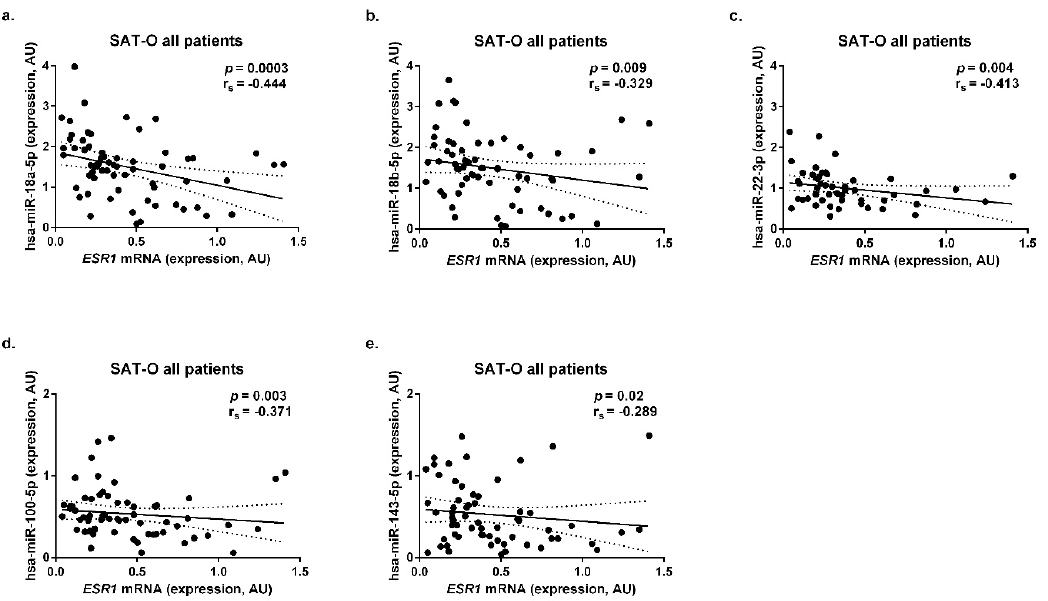
Figure 5. Correlations between ESR1 mRNA concentrations and hsa-miR-18a-5p ( a ), hsa-miR-18b-5p ( b ), hsa-miR-22-3p ( c ), hsa-miR-100-5p ( d ), and hsa-miR-143-5p ( e ) levels in the subcutaneous adipose tissue (SAT) of all obese (O) study participants. AU—arbitrary units.